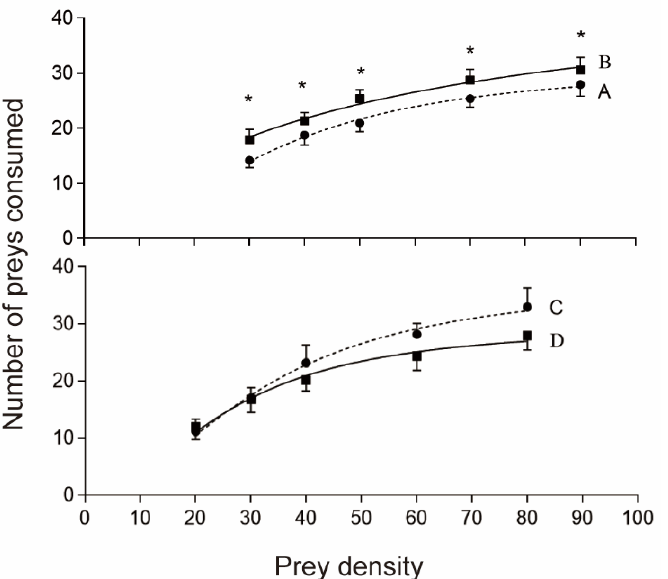
difference (Tukey test, p = 0.05).